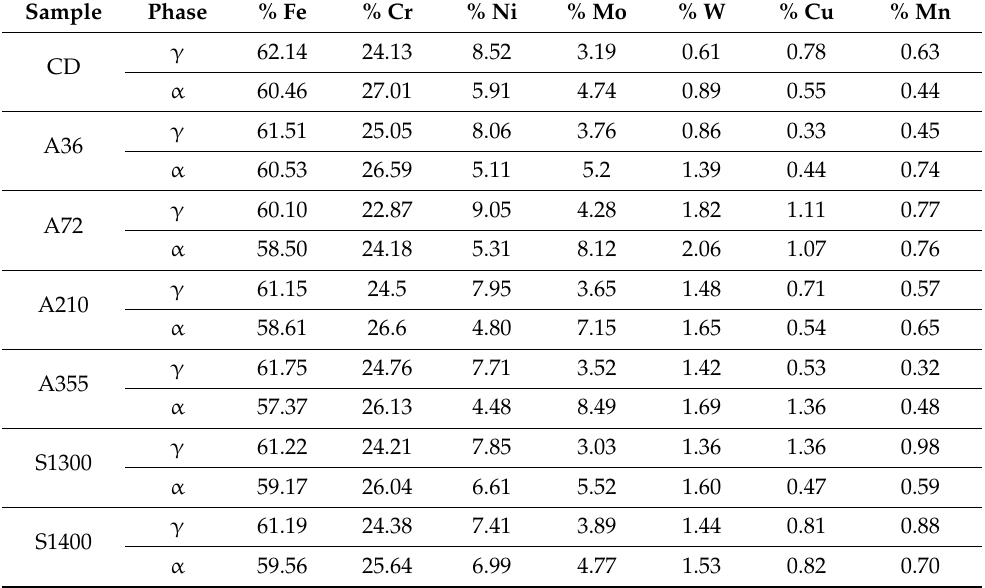
Table 5. Chemical composition measured within austenitic and ferritic